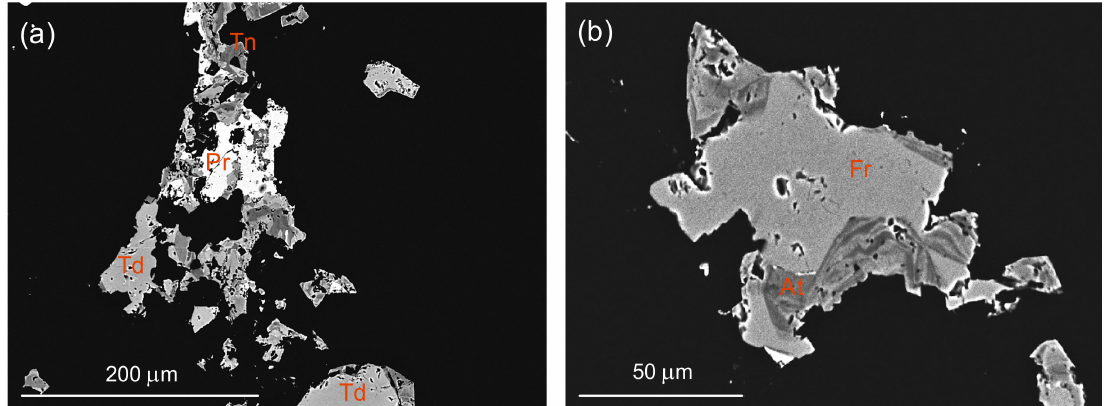
Figure 13. ( a ) Aggregates of members of Ag-rich tetrahedrite (Td)–tennantite (Tn) solid solution in association with proustite (Pr); ( b ) zonal aggregate of freibergite (Fr) and argentotennantite (At); both back-scattered electron (BSE)